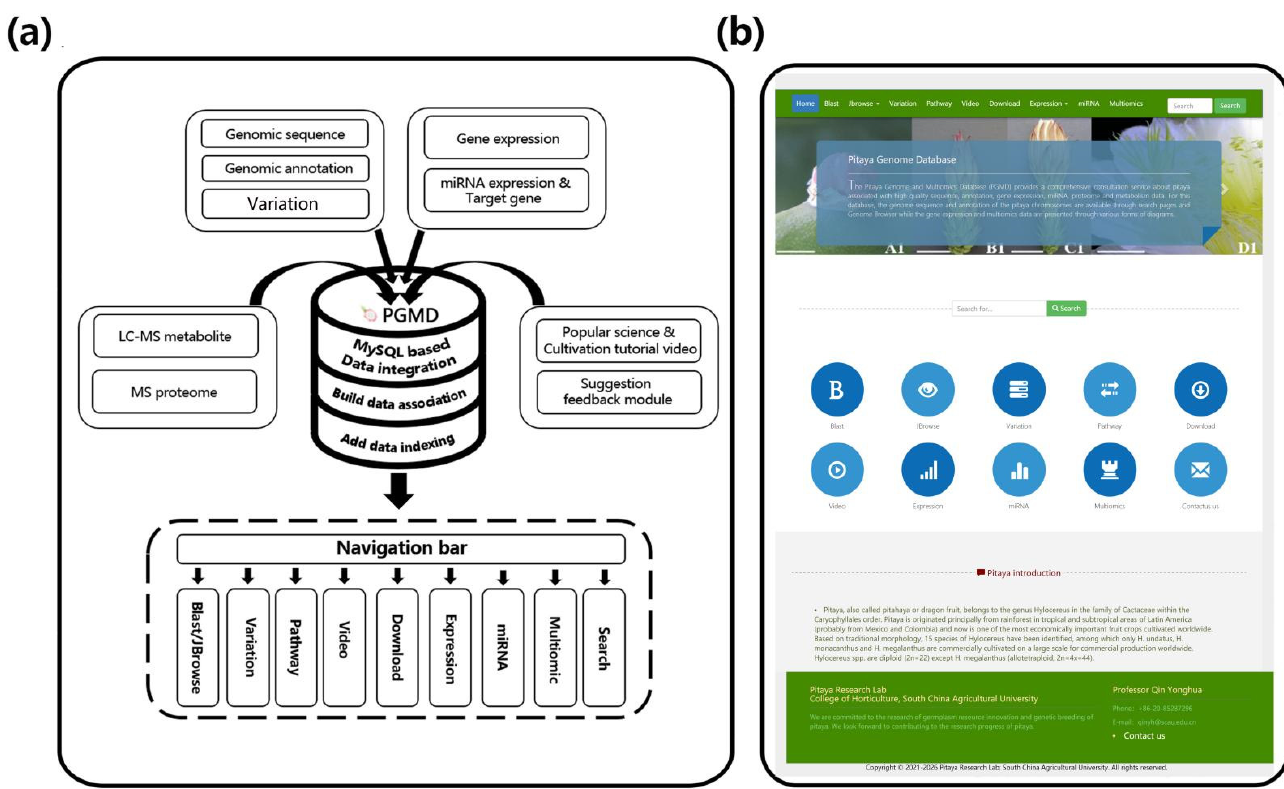
Figure 1. The flow diagram and home page of PGMD. ( a ) The flow diagram of PGMD. ( b ) The home page of PGMD.